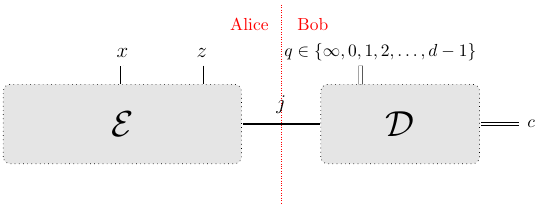
FIG. 3. Prepare-and-measure protocol for the Torpedo Game: Alice receives dits x and z and sends a single message (cid:4) (cid:5) (qu)dit j via the encoding E . Bob is asked a question (cid:4) ψ q ∈ {∞ , 0, . . . , d − 1 } , performs decoding D , and outputs c , x 1 , x 2 which should satisfy the winning conditions given by w q ( x , z ) with high probability.